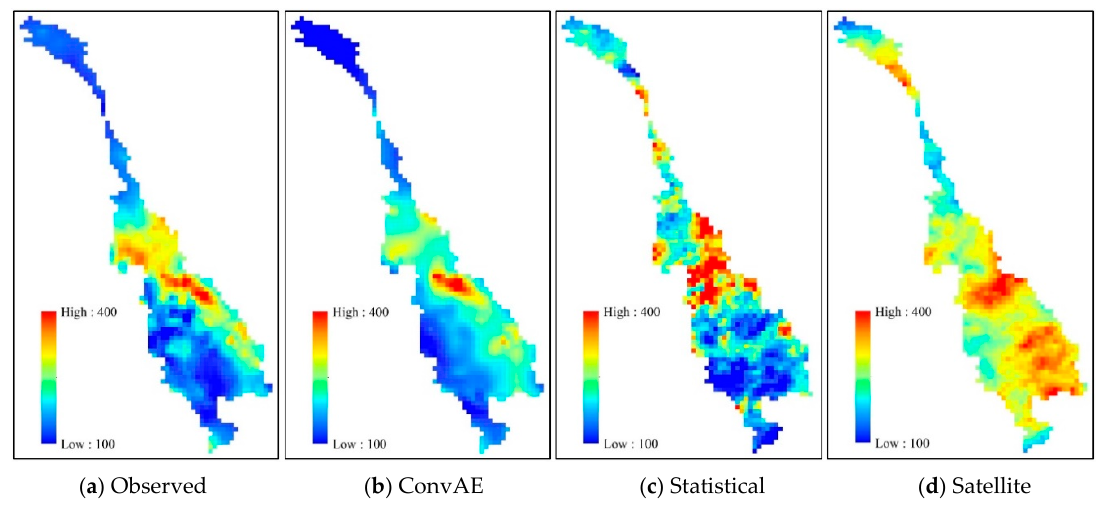
Figure 14. Spatial distribution pattern of the precipitation products in August 2014.